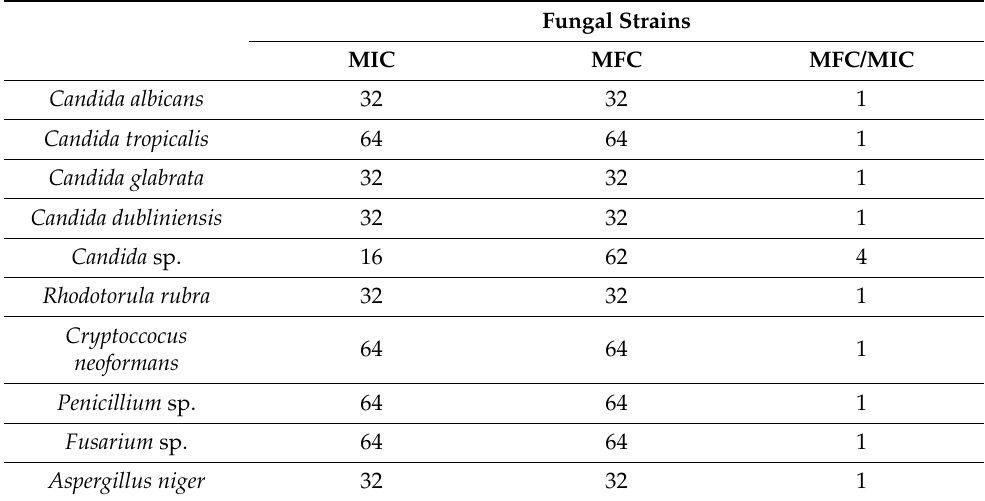
Table 7. The effect of the C. ladanifer essential oil on the MIC and MFC of the selected fungi